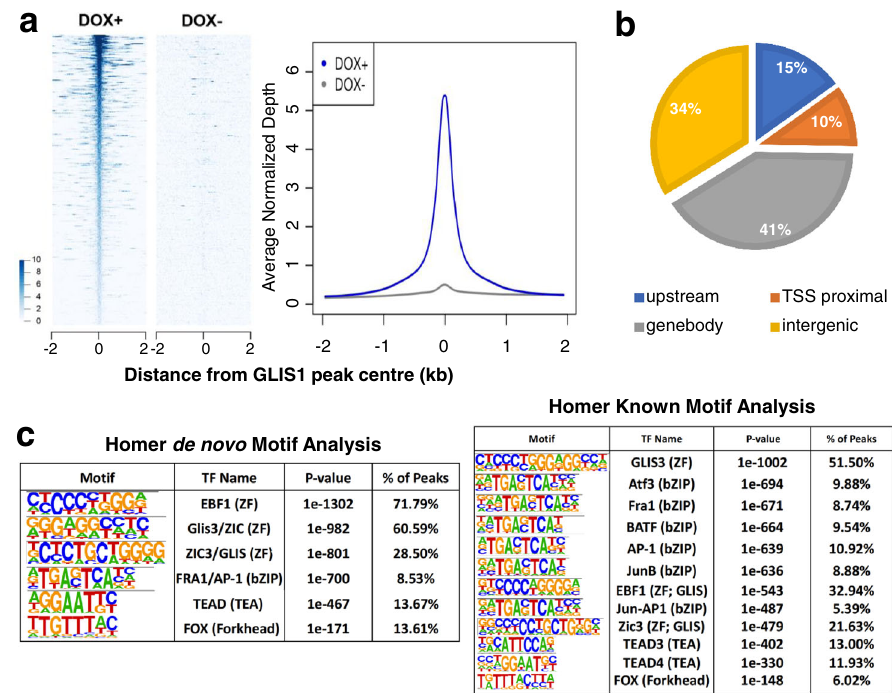
Fig. 5 GLIS1 regulates the transcription of a subset of TM/glaucoma-related genes in HTM cells through its interaction with GLISBS. a Heatmap and ChIP-Seq read density plot showing GLIS1 occupancy in TM5(pIND-GLIS1) cells treated for 18 h with Dox ( + Dox) compared to untreated cells ( − Dox). Each line in the heatmap represents an individual GLIS1 binding site. b Pie chart showing the location of GLIS3-binding peaks within speci fi c regions of the genome. TSS proximal: − 1 kb to the transcription start site (TSS); upstream: − 1 to − 10 kb. c Homer de novo and known motif analysis identi fi ed GLIS-like binding sites (GLISBS) as the top consensus sequence motif. Binding sites for transcription factors of the AP-1, FOX, and TEAD families were identi fi ed alongside GLIS consensus